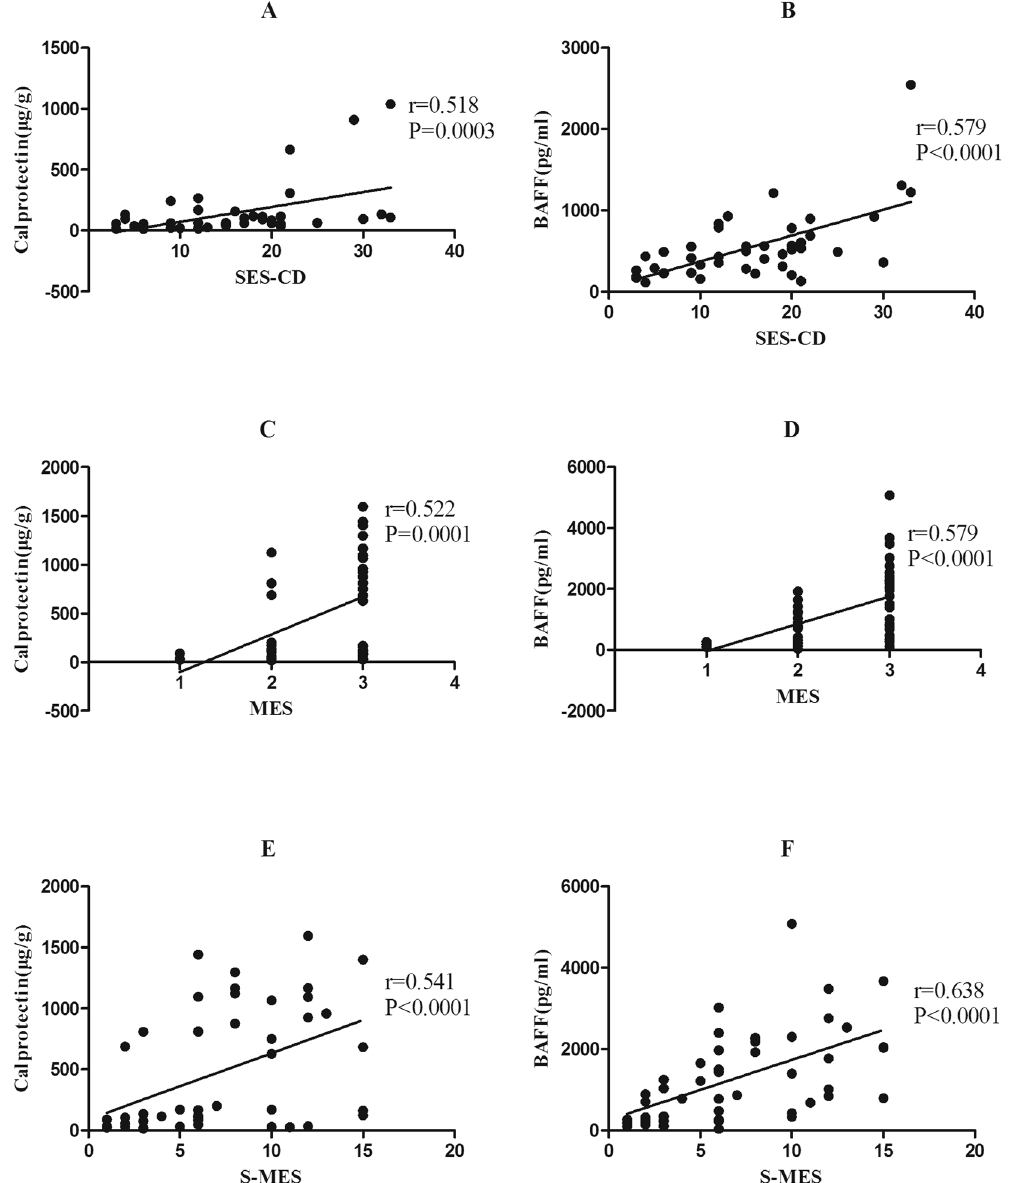
Figure 3. The correlations between faecal markers and the endoscopic inflammation score for patients with CD (SES-CD) and UC (MES and S-MES). ( A , B ) The faecal calprotectin and BAFF results were significantly correlated with SES-CD (Spearman’s rank correlation coefficient [r] = 0.518, P = 0.0003 and r = 0.579, P < 0.0001, respectively). ( C , D ) The faecal calprotectin and BAFF results were significantly correlated with MES (r = 0.522, P = 0.0001 and r = 0.579, P < 0.0001, respectively). ( E , F ) The faecal calprotectin and BAFF results were significantly correlated with S-MES (r = 0.541, P < 0.0001 and r = 0.638, P < 0.0001,